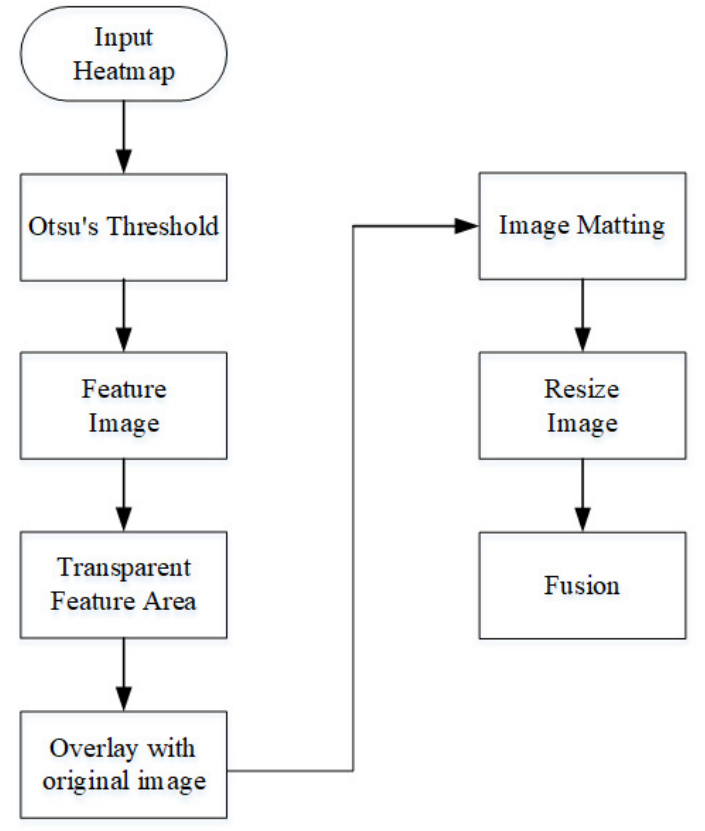
Figure 4. Heterogeneous fusion algorithm flowchart.